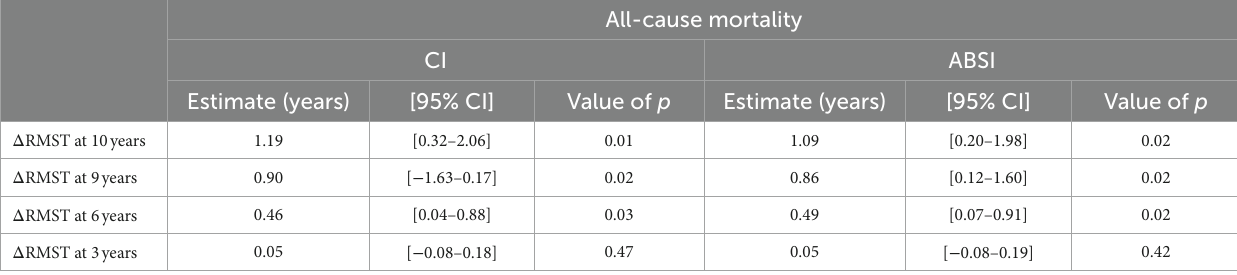
TABLE 6 The age-weighted restricted mean survival time (RMST) analysis adjusted for gender, DM, CVD, and total